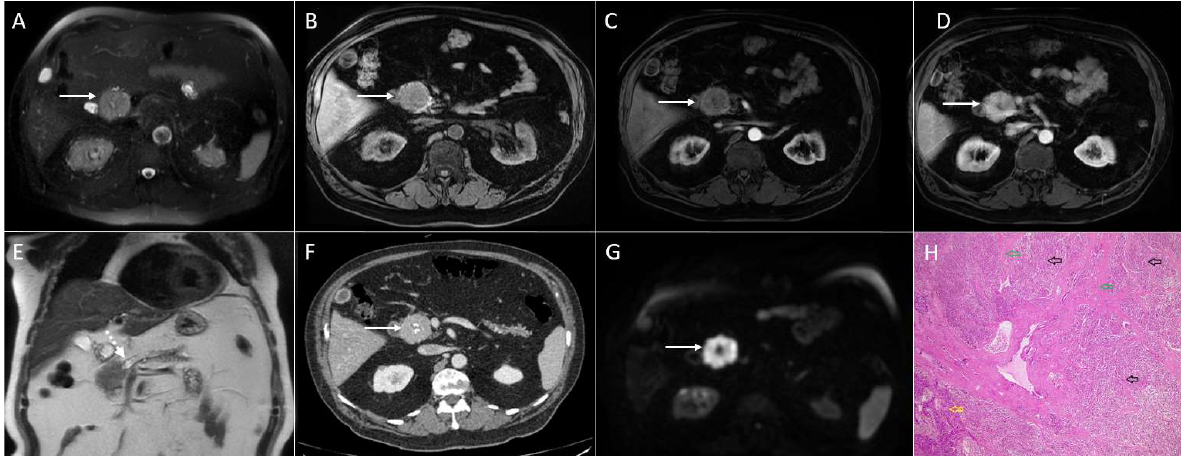
Figure 4. Sixty-eight-year-old man with solid pseudopapillary tumor. Axial T2-weighted FS image ( A ) shows slightly lobulated hyperintense lesion in the pancreatic head ( arrow ). On native T1-weighted FS image ( B ), the tumor is hypointense. After intravenous contrast administration, the lesion is only slightly enhanced in arterial phase ( C ). Portal-venous phase in the same patient ( D ) shows progressive enhancement of the lesion. The tumor leads to the obstruction of the main pancreatic duct, which is dilatated in the body and the tail of the pancreas as is seen on coronal T2-weighted image ( dashed arrow ) ( E ). On the axial DWI ( F ), the tumor shows restricted diffusion with central hypointense area ( arrow ). Corresponding CT image ( G ) better depicts central scar with punctiform calcifications ( arrow ). Hematoxylin and eosin (H&E) staining ( H ) showed solid pseudopapillary tumor ( black arrows ) with fibrous septations ( green arrows ). Normal pancreatic parenchyma is also shown ( yellow arrow ); original magnification ×400.